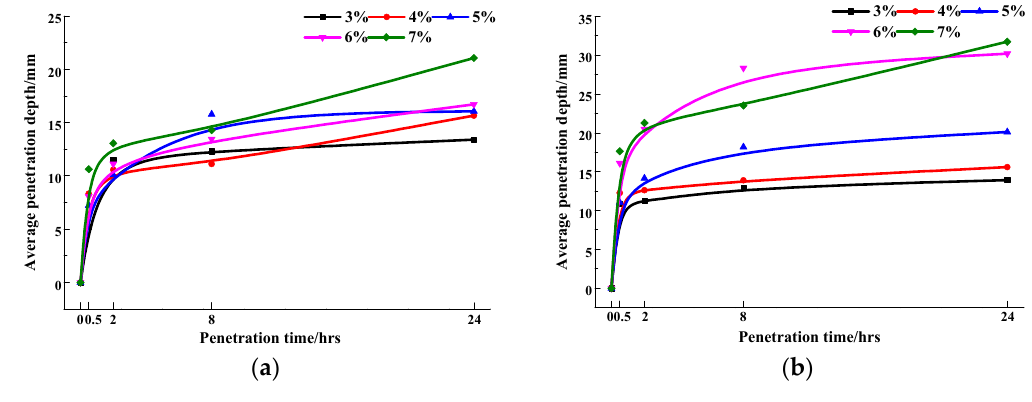
Figure 8. The comparison of average penetration depth. ( a ) 0.5 kg/m 2 ; ( b ) 1 kg/m 2 .